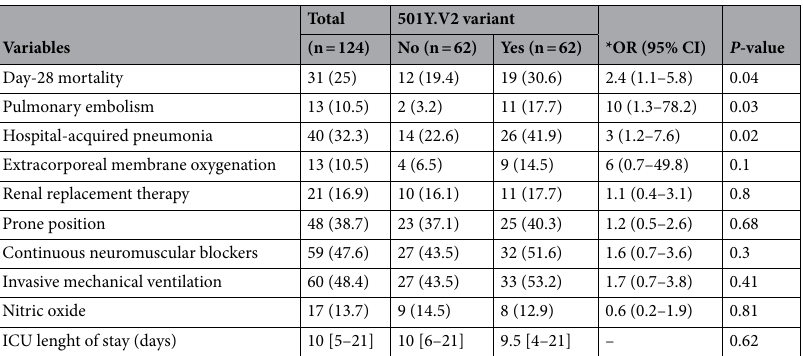
Table 3. Outcome of the 124 matched patients during intensive care unit stay. Results are expressed as total numbers (percentages) for categorical variables and as medians [25th–75th percentiles] for continuous variables as appropriate. ICU intensive care unit, OR odds ratio, CI confidence interval. *OR and 95%CI were estimated using univariate conditional logistic regression. Doubly Robust Matching Estimator : 0.12 (95% CI